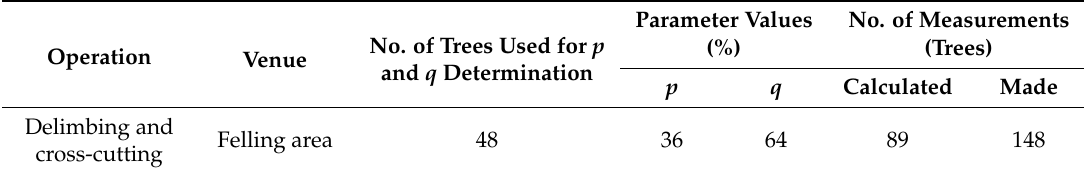
Table 3. Minimum number of